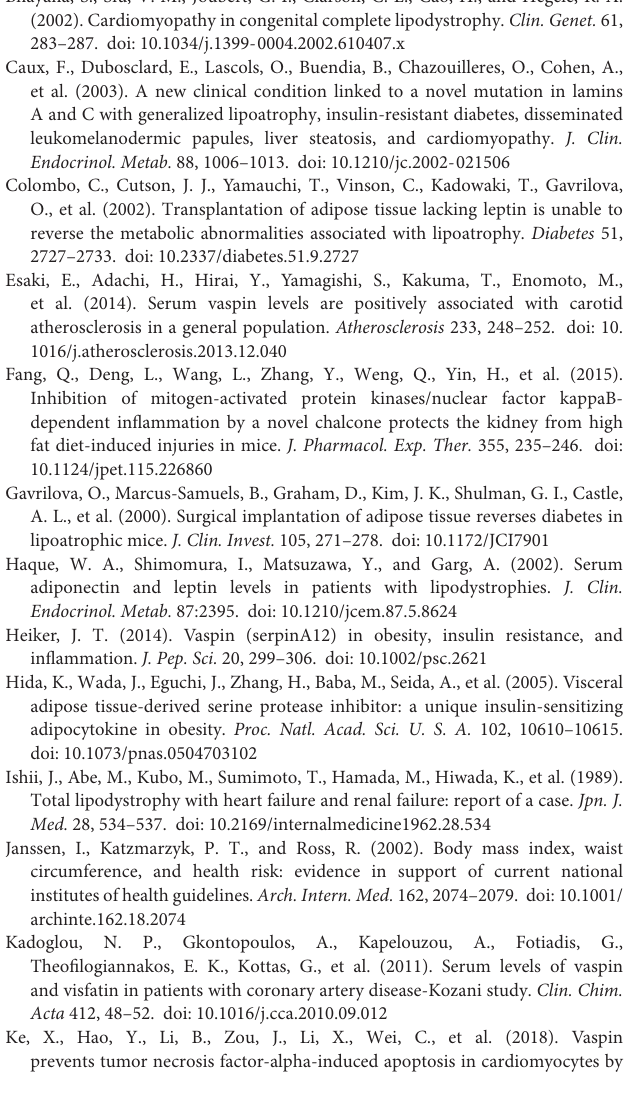
sacrificed, and the cardiac AKT activity was analyzed. Results are showed as mean ± SEM, and n = 6–8 mice/group. ∗∗ p < 0.01, ∗∗∗ p < 0.001. Supplementary Figure 6 | The effects of vaspin on AKT/GSK3 β activity. 1 10 6 primary cardiomyocytes were treated with different concentrations of recombinant vaspin protein (0, 0.05, 0.25, and 2.5 µ g/ml) for 24-h. Western blot analysis of p-AKT, AKT, p-GSK3 β , and GSK3 β (A) , and quantitative analysis of relative density (B) . Results are showed as mean ± SEM, and n = 5 independent experiments. ∗∗ p < 0.01. Supplementary Figure 7 | The efficiency of lentivirus encoding siAkt in cardiomyocytes and downstream mitochondrial changes. (A) 1 10 6 primary cardiomyocytes were incubated with 1 10 5 viral particles encoding si Akt for 48-h (#1 and #2), and western blot analysis of AKT expression. (B) The mitochondrial gene expression in cardiomyocytes treated with lentivirus encoding siAkt (#2). Results are showed as mean ± SEM, and n = 5 independent experiments. Supplementary Table 1 | Echocardiographic analysis of mice transplanted with adipose tissue with or without lentivirus encoding vaspin